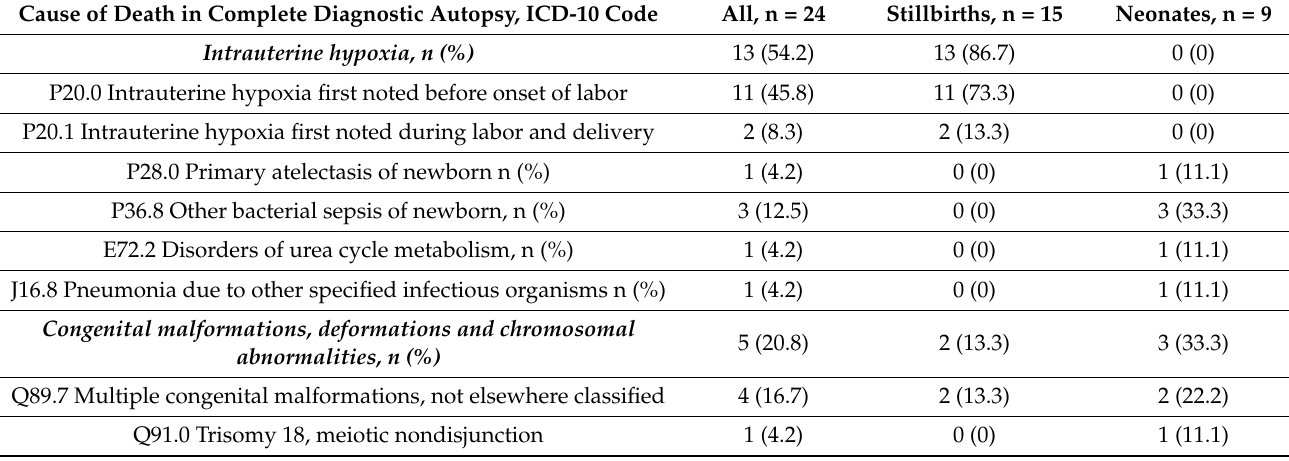
Table 2. Causes of deaths among all, stillbirths and neonates determined by complete diagnostic autopsy.